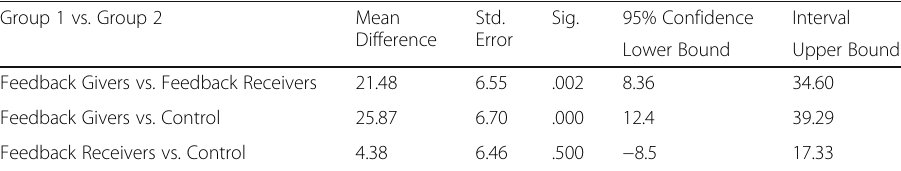
Std. Sig. 95% Confidence Interval Difference Error Lower Bound Upper Bound